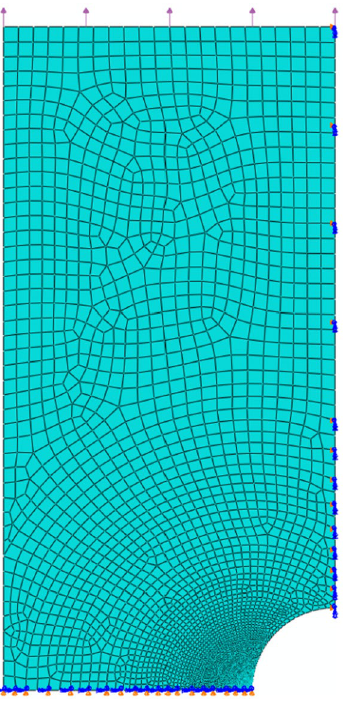
Fig. 3 Quarter symmetry mesh model for plate with hole diameter 0.25 the plate width